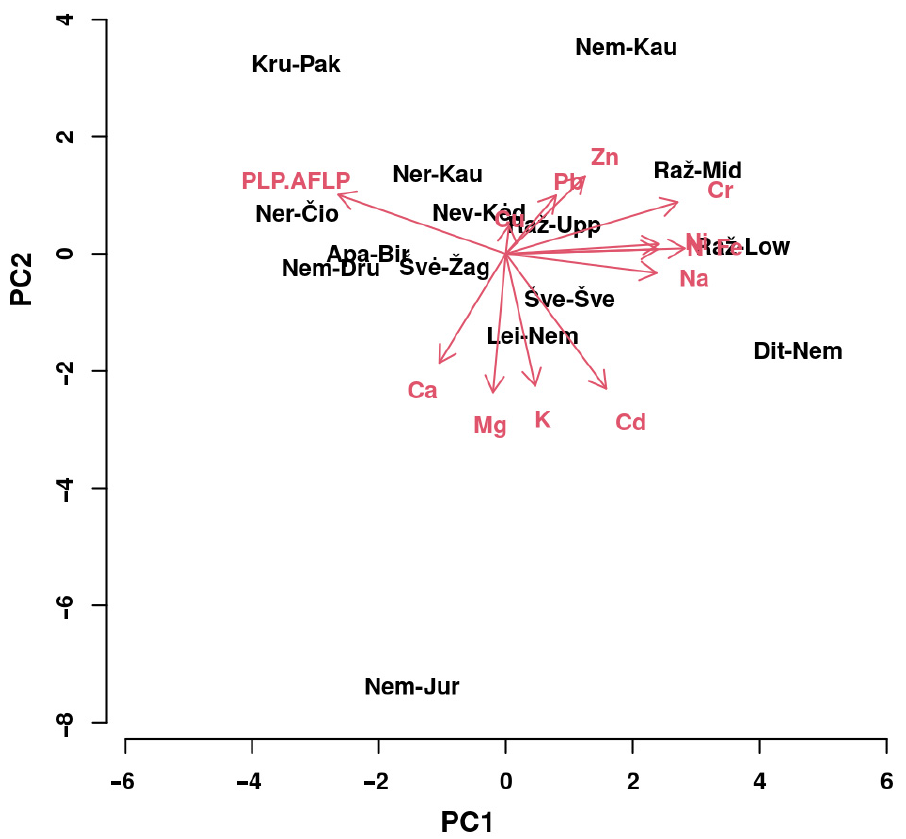
Figure 7. Biplot of the principal component analysis for the first two principal components of a model testing variation of Lythrum salicaria populations depending on PLP at AFLP loci and concentrations of macronutrients (N, K, Ca, and Mg), Na, micronutrients (Fe, Zn, and Cu), and non-essential elements (Pb, Ni, Cr, Cd). Titles of populations are in black letters (Figure 1; Table 1), and red arrows with letters denote variables.